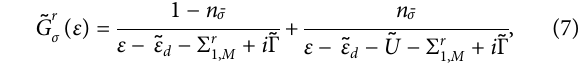
FIGURE 1 | Electrical current and heat generation varying with respective to the bias voltage when the QD is coupled to MBSs. (A) and (B) are for ε ̃ d (cid:1) 0 whereas ε ̃ (cid:1) ω q in (C) and (D) . The two arrows in Figure 1D indicate the two NDHG. The dot-MBSs coupling strength d Γ